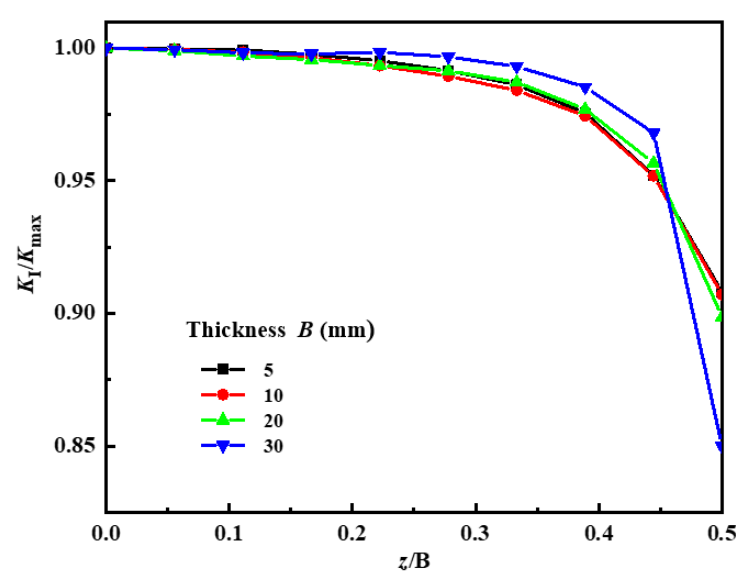
Figure 3. Variation of stress intensity factor (SIF) along straight crack thickness direction.